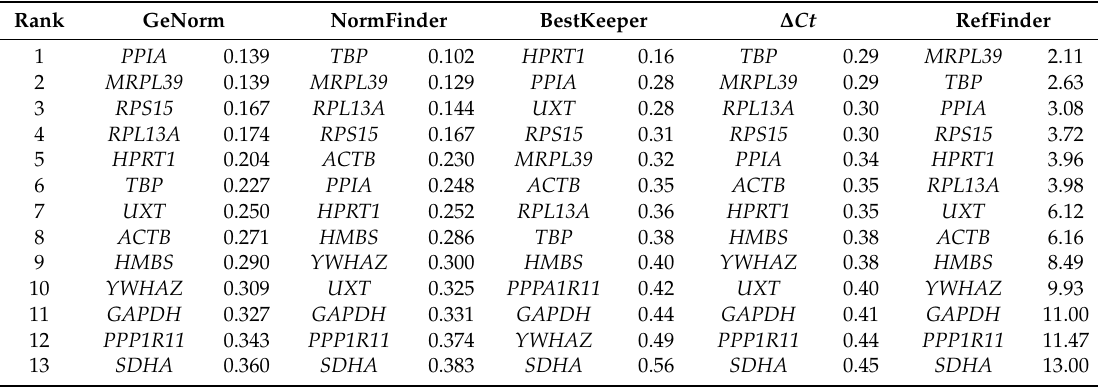
Table 4. Stability of RGs in mature stages of yak